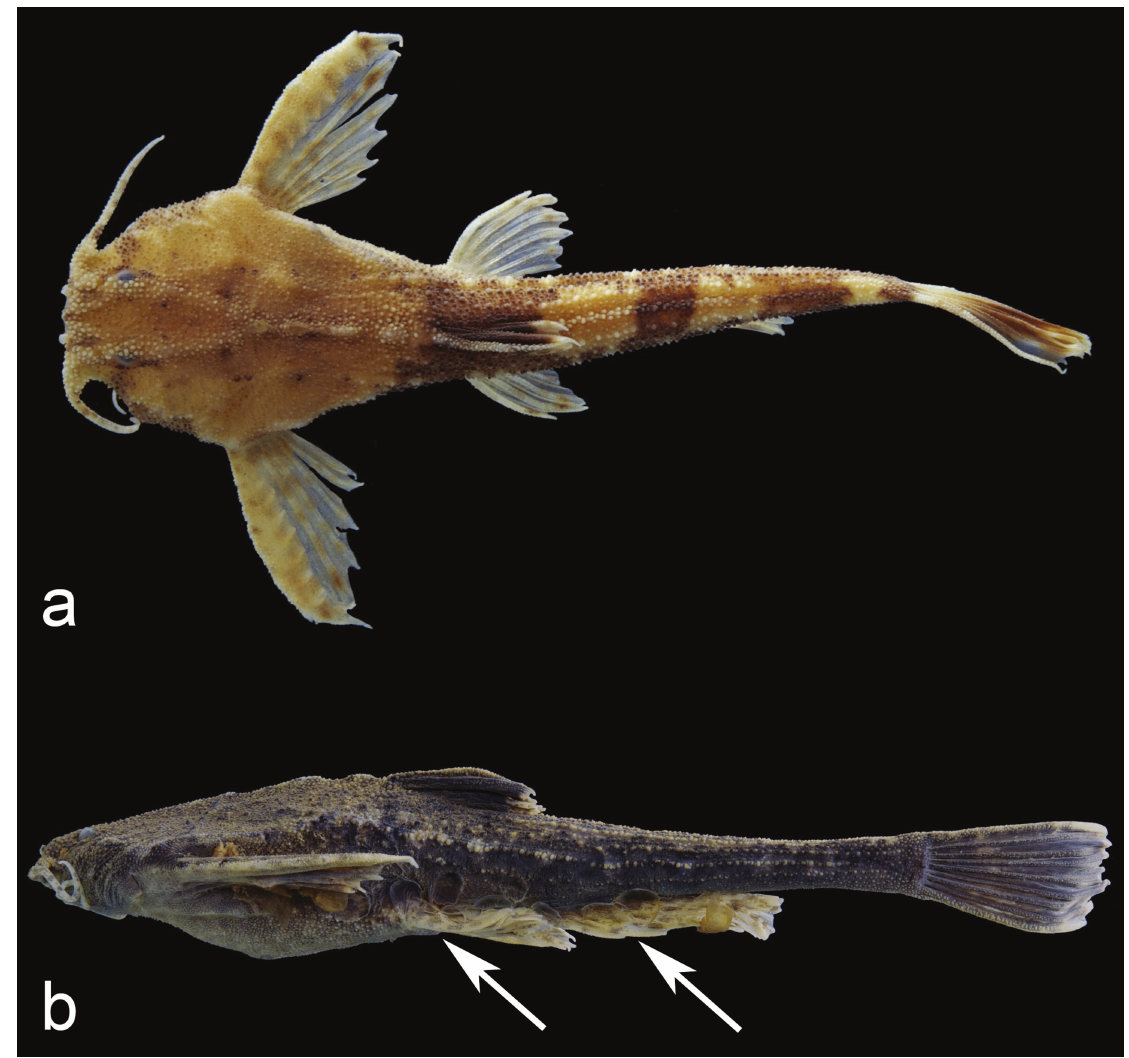
Fig. 6. Paratype specimens of Bunocephalus minerim . a. Dorsal view of MCP 34665, 31.5 mm SL; showing the saddled pattern of a distinct color morph. b. Left lateral view of a mature female, MCP 45242, 41.4 mm SL, showing the eggs adhered and marks of previously attached eggs on the lateral and ventral portions of body and